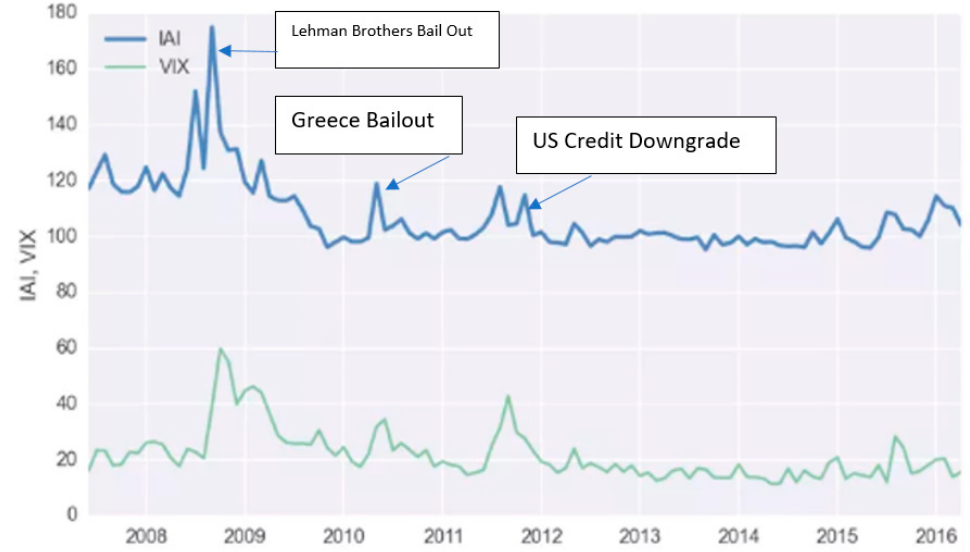
Figure 1. Anxiety and VIX Index. Source: www.investopedia.com / anxiety-index-explained.